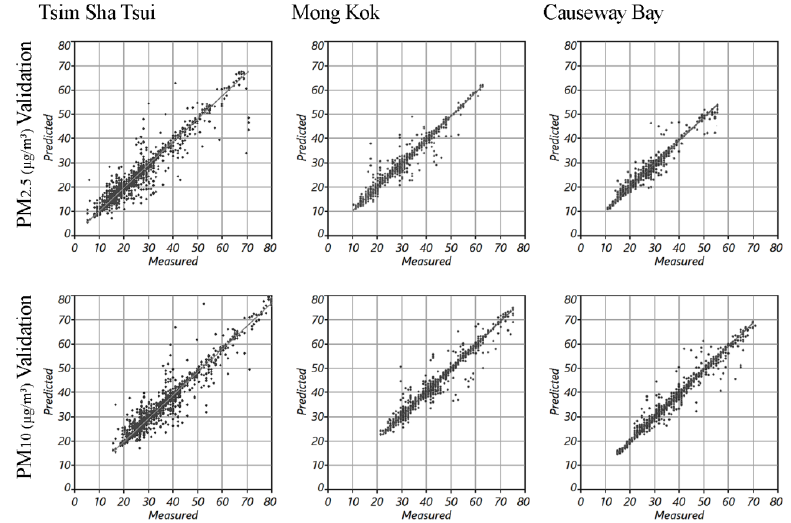
Figure 6. The validation of all resultant interpolation mappings of the PM 2.5 and PM 10 concentration in the three districts.